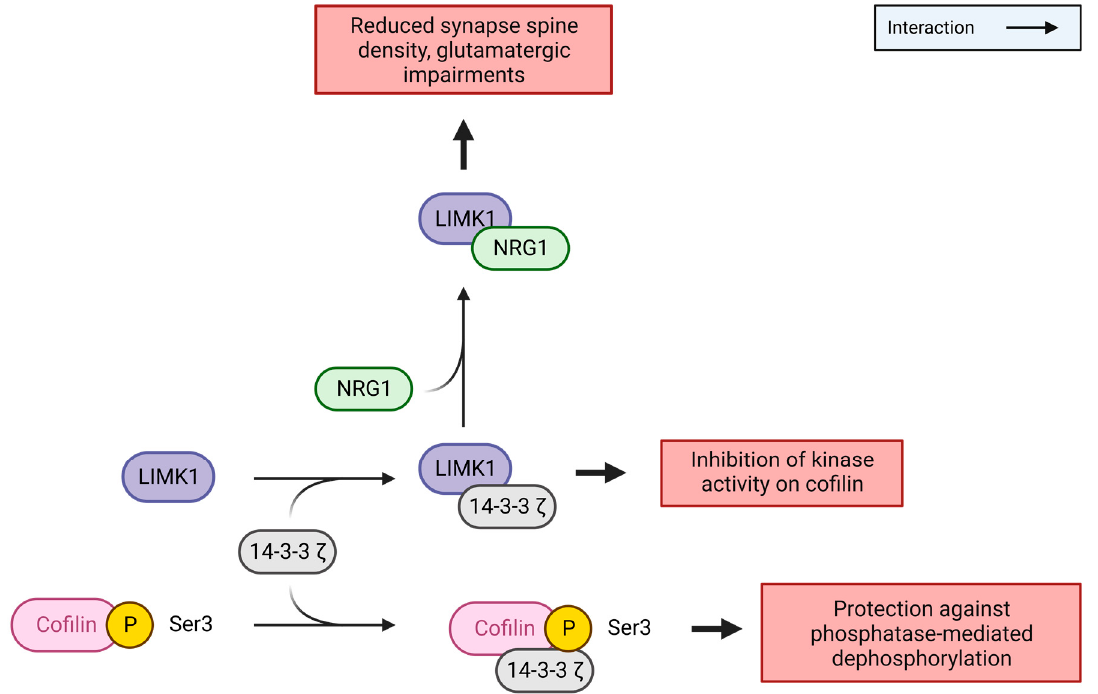
Figure 8. LIMK1 molecular implication in schizophrenia.